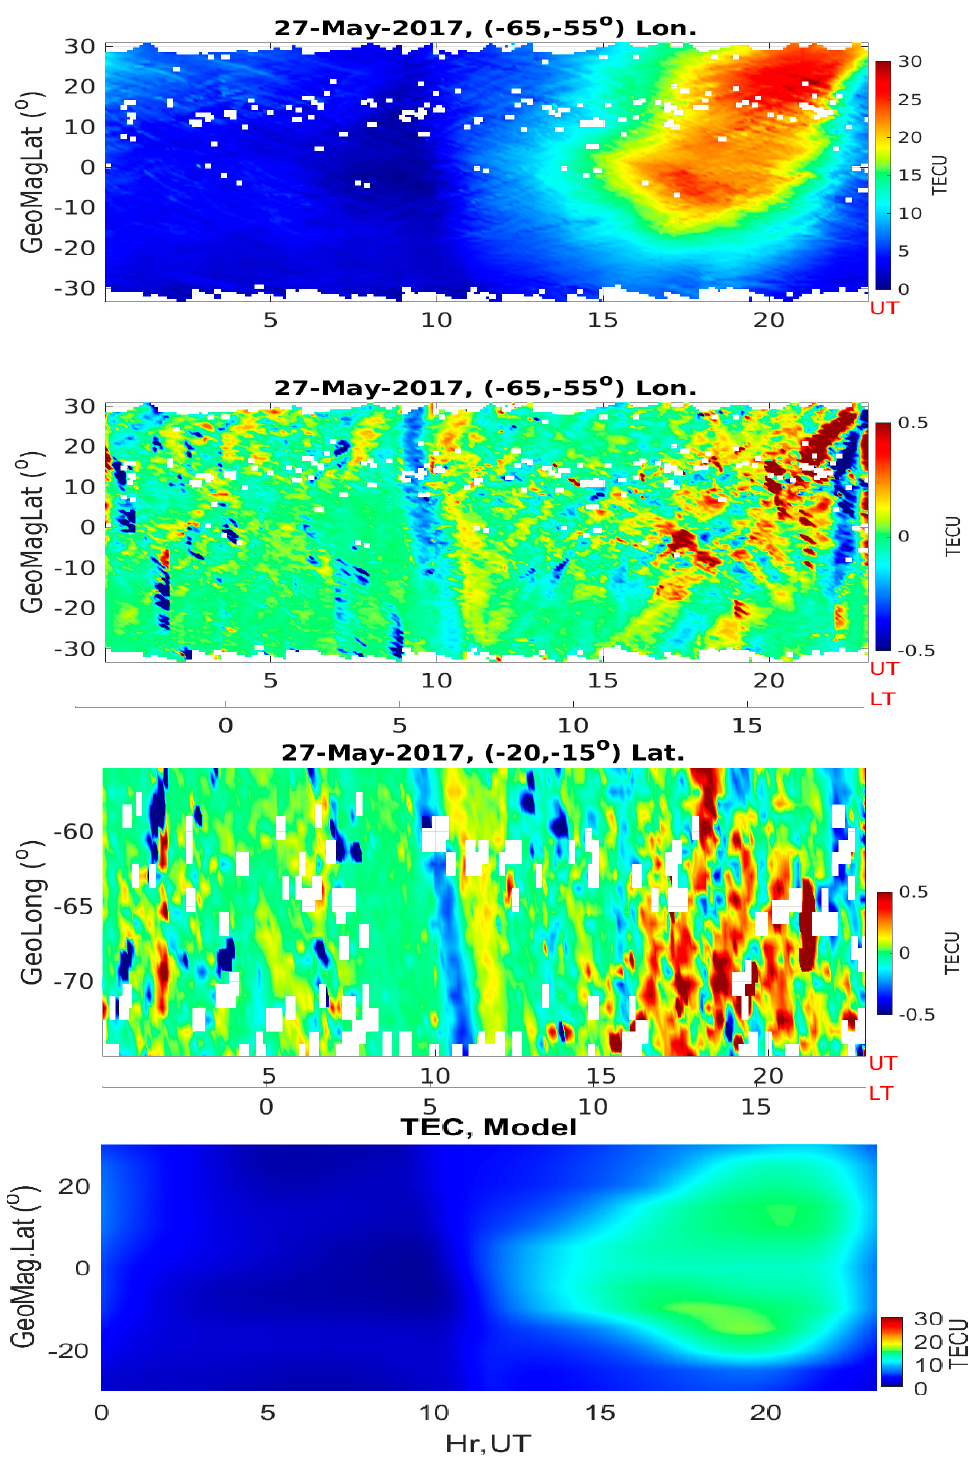
Figure 4. The same plots as Figure 3, but for a quiet day: 27 May 2017.